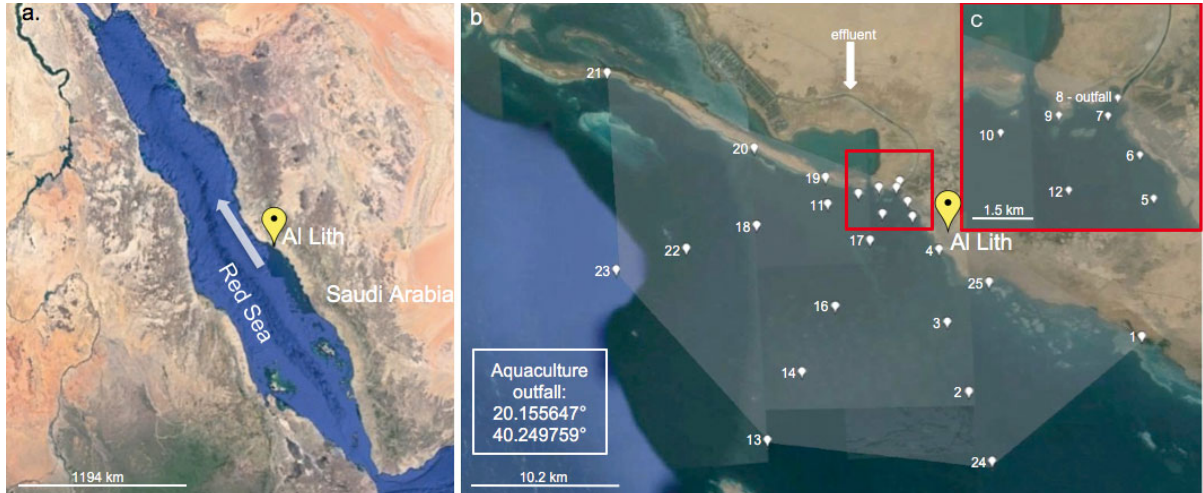
Fig. 1. (a) Location of the aquaculture facility in Al Lith, Saudi Arabia (yellow pin), in the eastern Red Sea. Gray arrow: the pre- vailing surface currents that move S to N, primarily along the eastern coast. (b) The 24 sites that were sampled along 5 tran- sects extending from the aquaculture outfall up to 21.7 km from the outfall. (c) Inset: a more detailed map of the outfall (Site 8) and nearby sites. Images reproduced according to Google permissions and incorporate data from NOAA, US Navy, National Geospatial-Intelligence Agency, General Bathymetric Chart of the Oceans, DigitalGlobe, and US Geological